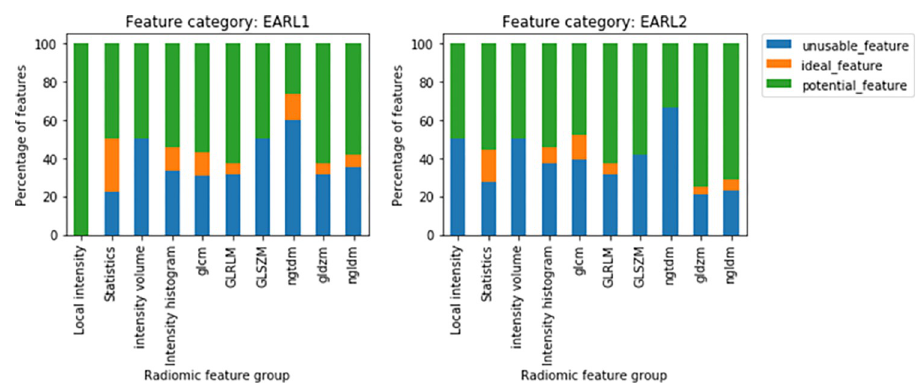
Fig 5. Percentage of features identified as unusable, ideal, and potential features per feature group for EARL1 (left) and EARL2 (right) reconstructed images.